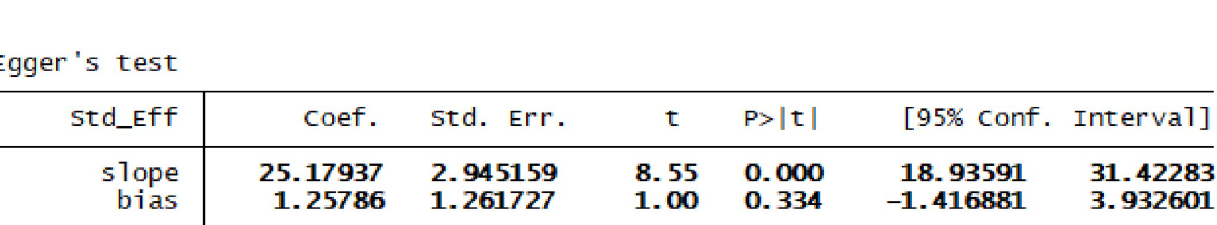
PLOS ONE | https://doi.org/10.1371/journal.pone.0250006 April 22, 2021 10 /